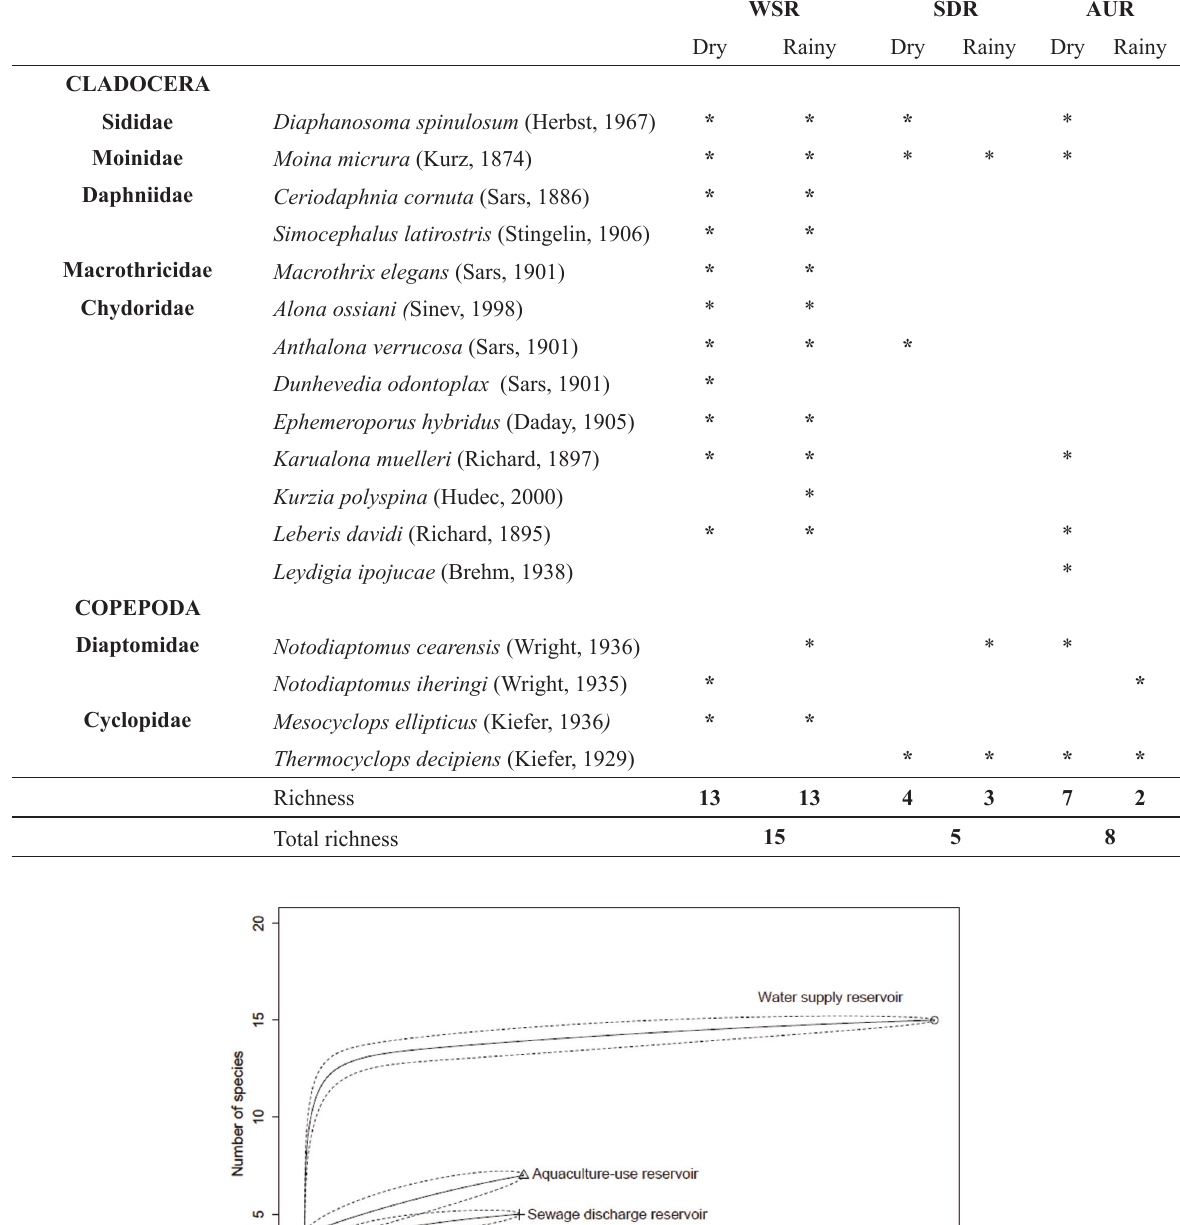
List of species of microcrustaceans (Cladocera and Copepoda) registered in the three reservoirs studied, in a tropical semiarid basin (Pajeú river). WSR = water supply reservoir (Cachoeira II), SDR = sewage discharge reservoir (Borborema) and AUR = aquaculture-use reservoir (Saco I).